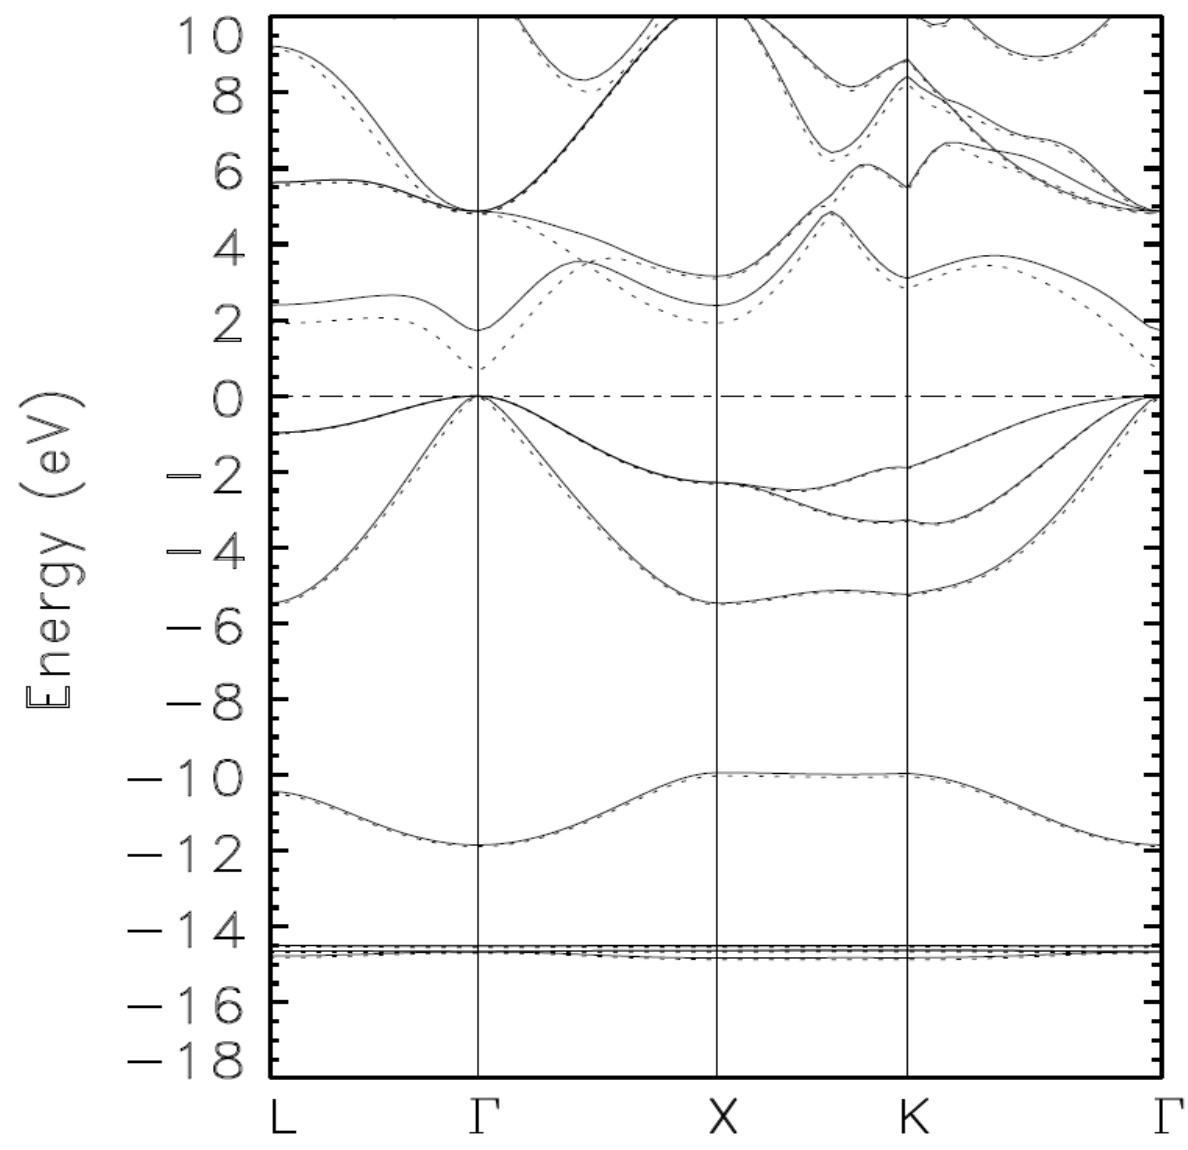
Figure 2. Calculated band structure of zinc blende indium arsenide (zb-InAS) as obtained by the BZW method from calculations II (full line) and III (dashed line). Most of the occupied bands are lowered by Calculation III, albeit only slightly, compared with Calculation II.